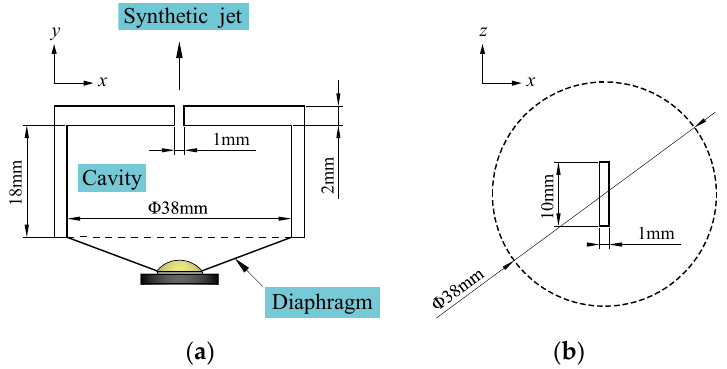
Figure 2. The synthetic jet actuator (SJA): ( a ) Front view; ( b ) Top view.